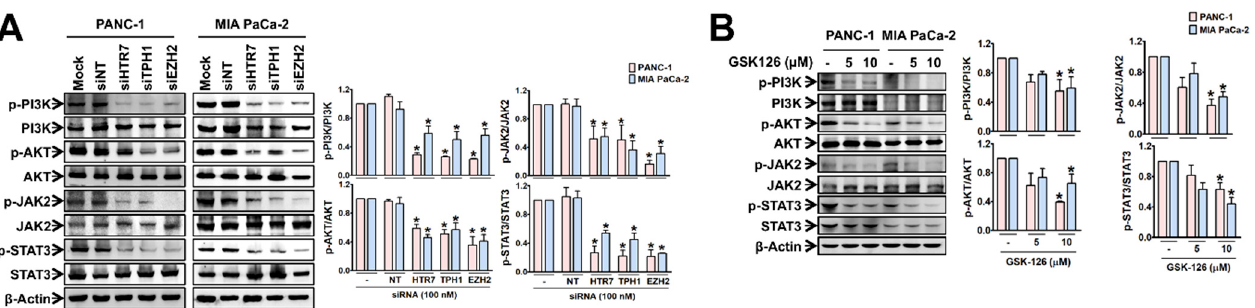
Figure 3. Effects of EZH2-TPH1-5-HT 7 axis inhibition on the activation of PI3K, Akt, JAK2, and STAT3 in PANC-1 and MIA PaCa-2 cells. ( A ) Cells were treated with siRNA of HTR7, TPH1, and EZH2. * p < 0.05, compared to siNT-transfected group. ( B ) Cells were treated with GSK-126 for 48 h. * p < 0.05, compared to vehicle-treated control group. The uncropped Western Blot images can be found in Figure S4.